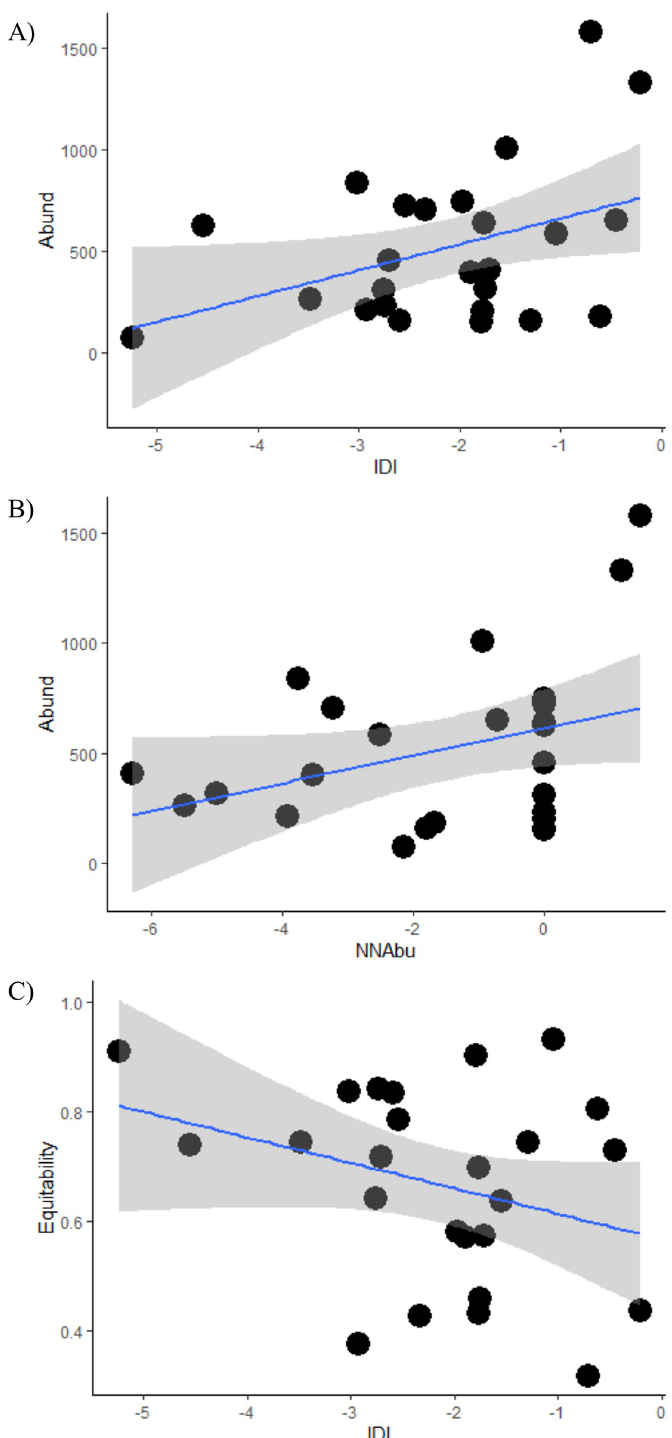
Fig 4. Relationships among the effect factors (x-axis) (log-transformed values) and metrics of fish assemblages’ structure (response variables, y-axis). The blue line represents the best fit of the Generalized Linear Mixed Models (GLMMs) to the data, and the gray shading area indicates the 95% confidence interval. A. Relations among numeric abundance (Abund) and Integrated Disturbance Index (IDI); B. Relations among numeric abundance (Abund) and non-native fish species abundance (NNAbu); C. Relations among equitability (Joule index) and IDI.